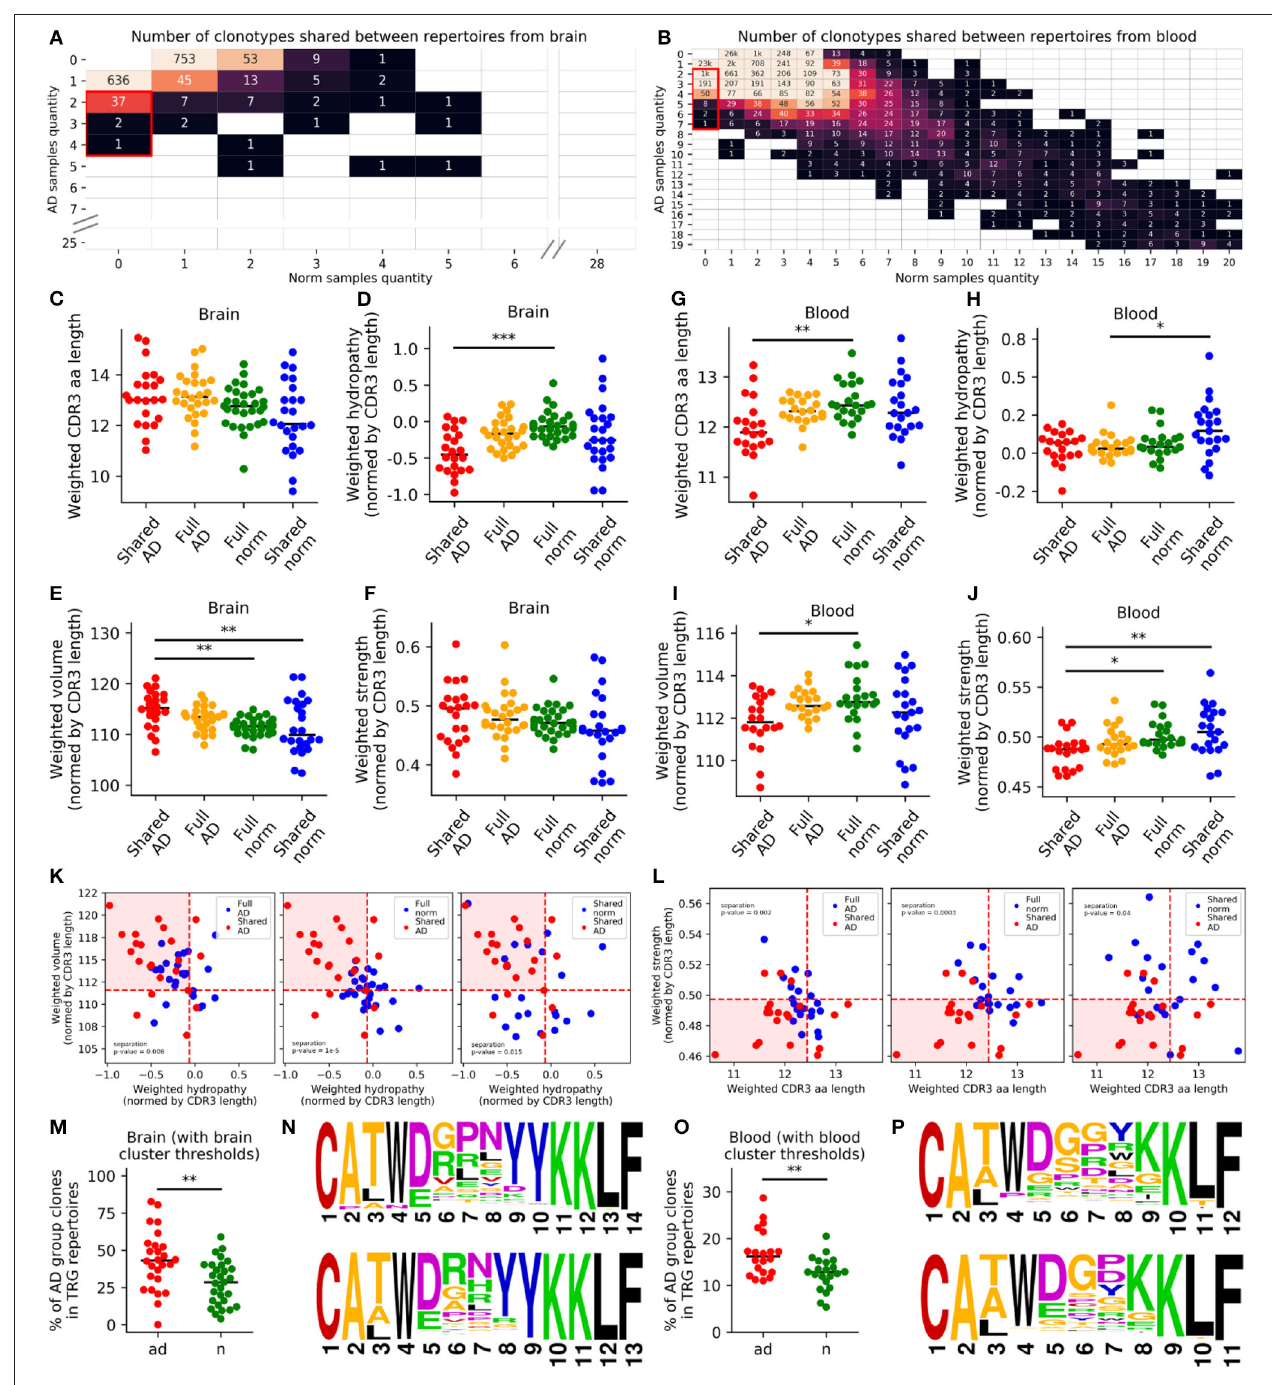
FIGURE 3 | TRG repertoires in Alzheimer’s patients included clones with specific properties in the blood or brain. We analyzed clones found in at least two patients, but not in healthy individuals (A,B) . Values in the matrices indicate numbers of clones found in the samples indicated along the axes. We compared the weighted CDR3 lengths (C,G) , hydropathy indexes (D,H) , volumes (E,I) , and strengths (F,J) between shared AD repertoires, full AD repertoires, total norm repertoires, and shared norm repertoires. For brain samples, values of volume and hydropathy were chosen (K) , and for blood, the CDR3 length and strength were chosen (L) , as characteristics defining AD-specific clone features. Clones with these characteristics were significantly more represented in patients with Alzheimer’s disease (M,O) . Logoplots of CDR3 amino acid sequences for brain (N) and blood (P) were compiled (orange, small and weakly interacting amino acids; red, small; violet, small, weakly interacting, and hydrophilic; green, hydrophilic and weakly interacting; blue, hydrophilic). * P < 0.05, ** P < 0.01, *** P < 0.001. Red dashed lines (K,L) denote median values for controls.